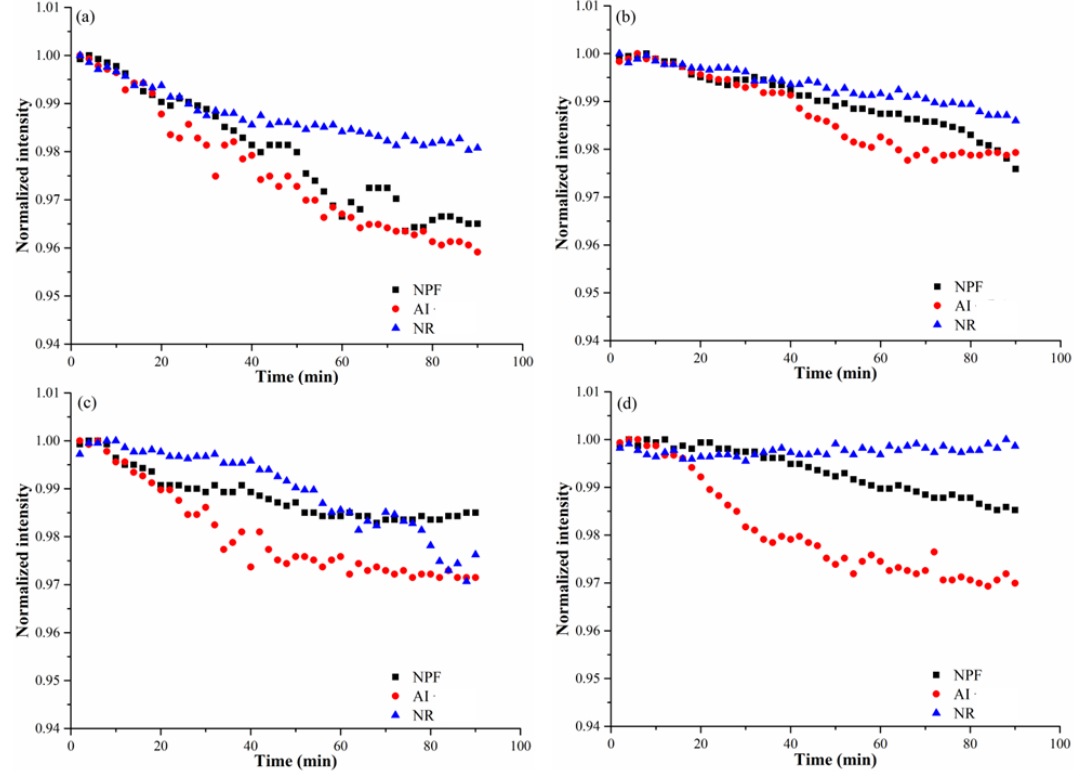
Figure 2. The sedimentation of NPF, AI and NR in different solutions as a function of time: ( a ) Ultrapure water; ( b ) HZ soil solution; ( c ) AJ soil solution; ( d ) TR soil